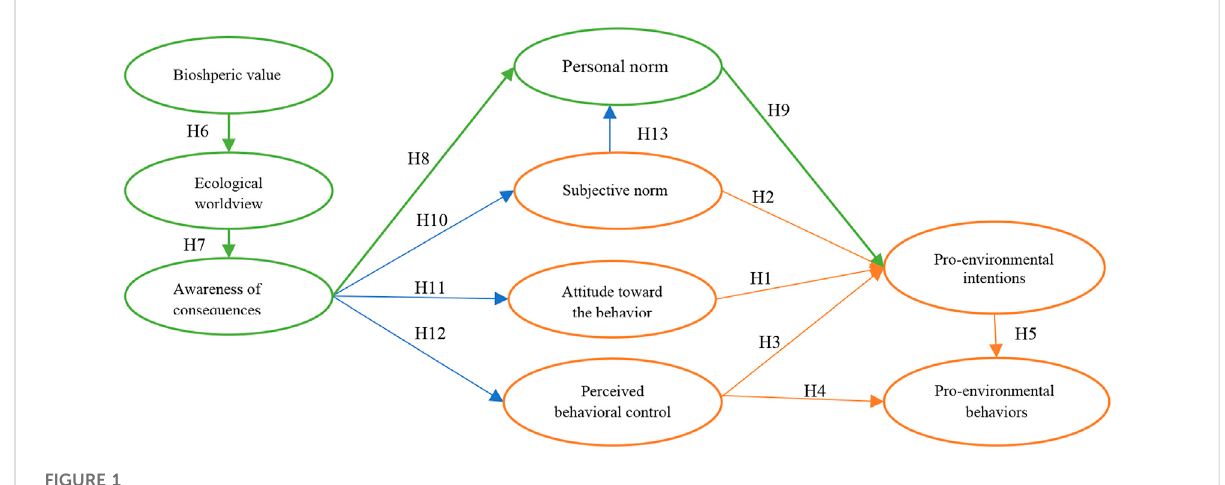
FIGURE 1 Research